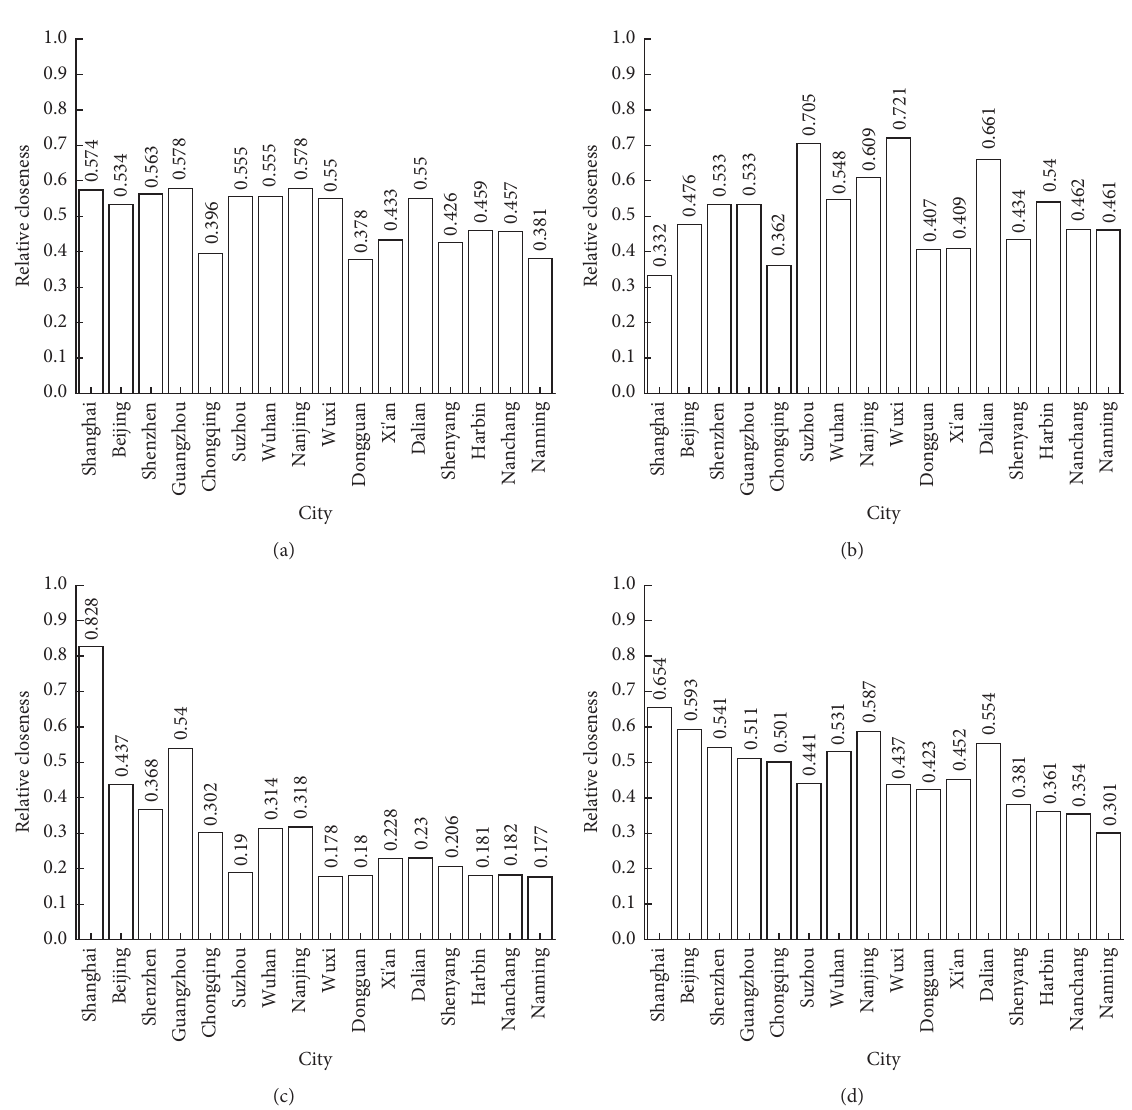
Figure 2: The relative closeness of different indicators in different cities: (a) public welfare, (b) policy loss, (c) social benefit, and (d) service